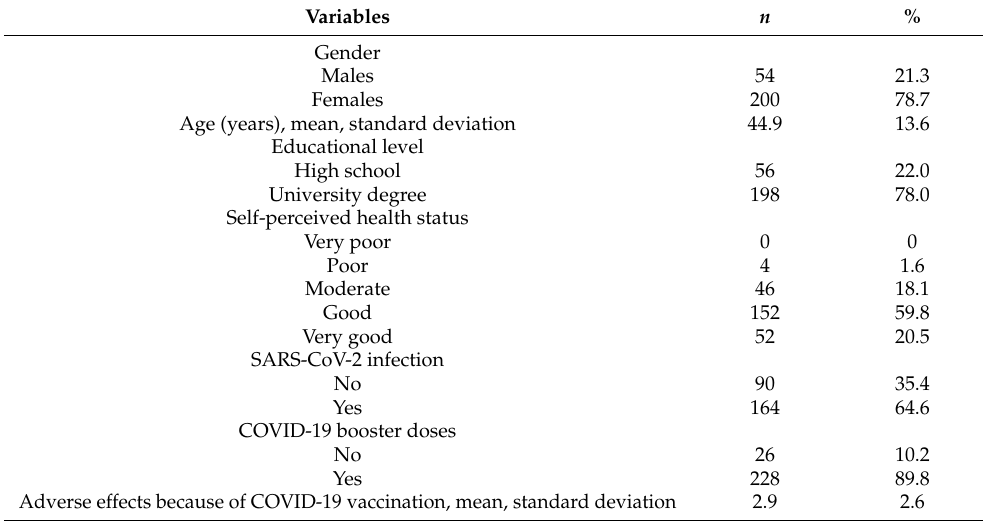
Table 1. Demographic and COVID-19-related variables of the study population ( n =